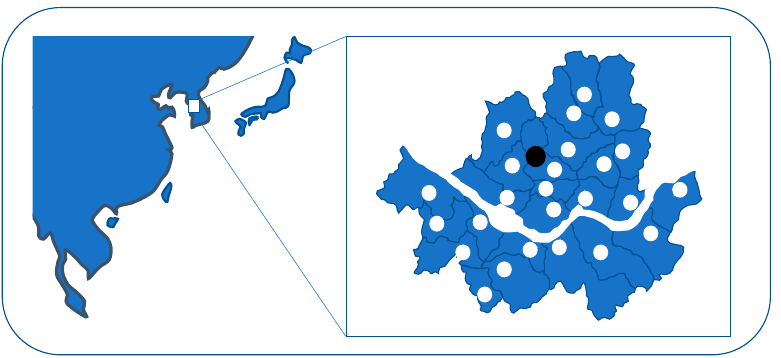
Figure 1. Location of 25 monitoring stations for air pollutant ( ○ ) and one station for